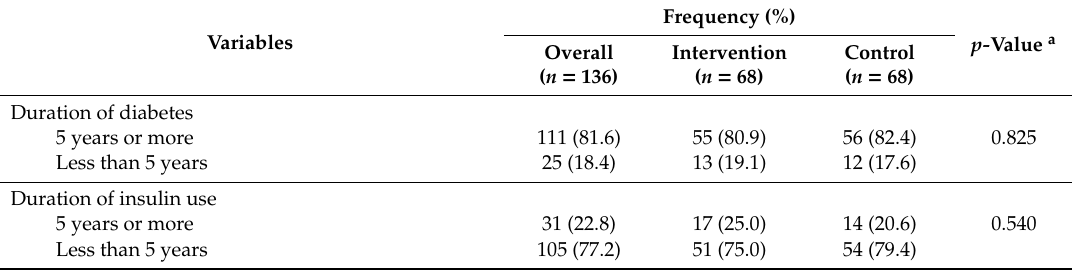
Table 2. Comparison of baseline clinical and sharp disposal characteristics between intervention and control groups ( n =